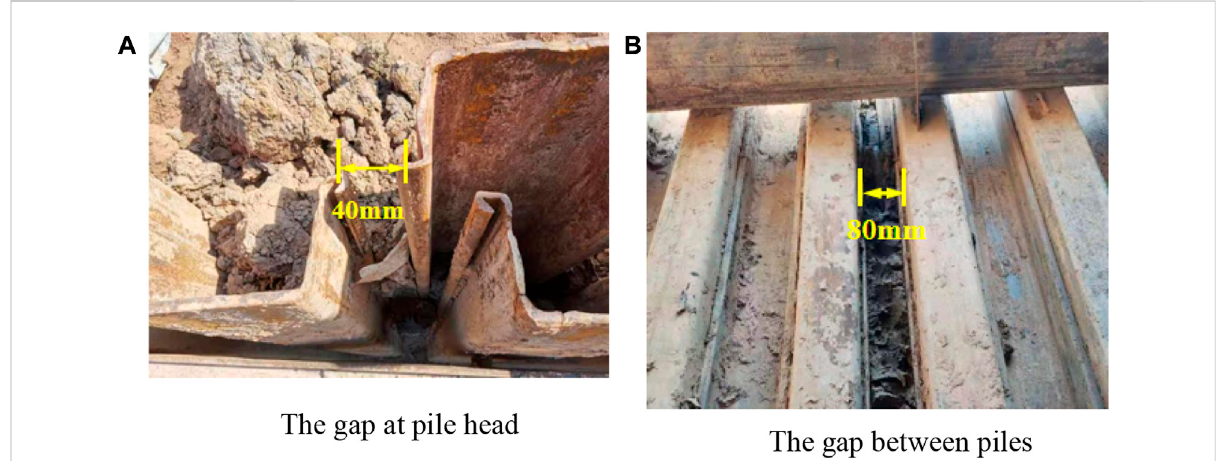
FIGURE 5 Steel-sheet pile above the anchor cables cannot be overlapped. (A) Gap at pile head. (B) Gap between